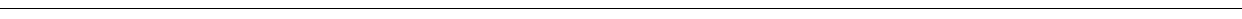
Fig. 1 Eroded telomeres are rearranged in quiescence. a Top, relative position of the restriction sites in the telomeric and subtelomeric regions of S. pombe chromosomes based on pNSU70. Telomeric (Telo) and subtelomeric (STE1) probes used for southern blot are represented. Bottom, genomic DNA from WT cells was digested with EcoR I and southern blotted. The membrane was hybridized with Telo, STE1, and chromosomic probes. R, replicative sample; M, molecular weight marker; 1, 4, 8 correspond to the number of days in quiescence. A chromosomal probe was used as a loading control. b Top, freshly deleted ter1 colony was maintained in exponential phase in liquid EMM medium for about 120 generations by serial dilutions. Population doublings were monitored by cell counting. Bottom, genomic DNA was digested with EcoR I and southern blotted. The membrane was hybridized with Telo and chromosomal probes. Asterisks indicate the time points of the replicative senescence kinetics that have been shifted to nitrogen-deprived medium. c Schematic representation of a typical senescence-quiescence coupled experiment. Cells collected at different type points of the senescence were shifted in deprived-nitrogen medium and maintained in senescence as indicated. d Genomic DNA from quiescent ter1 Δ cells was digested by EcoR I and southern blotted. Membrane was hybridized with Telo, STE1, and chromosomal probes. 1, 4, 6, 8 correspond to number of days for which cells were in G0 before collecting. S1, S3, S5, and S7 indicate the days during the senescence kinetics at which cells were starved from nitrogen. Subtelomeric rearrangements are shown by asterisks. e Genomic DNA from quiescent WT and ter1 Δ cells at S3 and S5 was spotted onto Hybond-XL membrane and hybridized with the indicated probes. Signal quanti fi cation has been performed with “ Quantity one ” software and STE1/Control ratio was